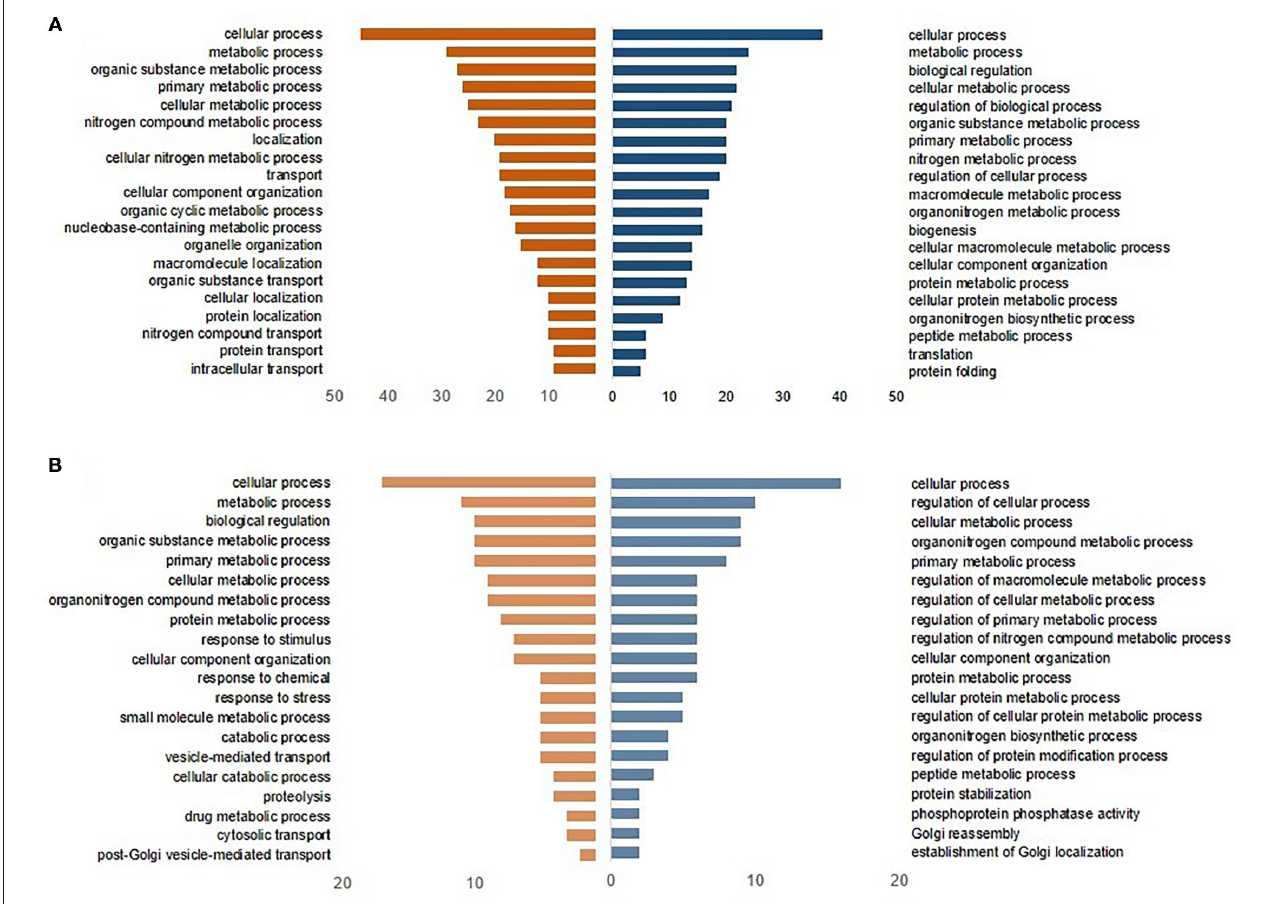
FIGURE 3 | Gene Ontology (GO)-enriched terms of intestinal differentially expressed proteins from broilers exposed to Citrobacter freundii (CF) in ovo (A) at the day of hatch and (B) by 10 days of age. The blue bars to the right indicate the most GO-enriched terms by upregulated proteins. The orange bars to the left represent GO terms enriched by downregulated proteins, while the axis at the bottom is the number of proteins in each biological